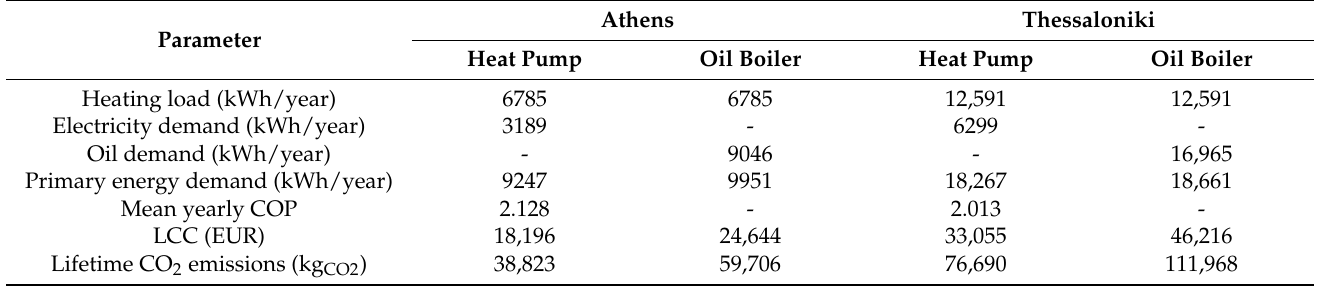
Table 4. Comparison of the performance of the two heating systems for both locations.